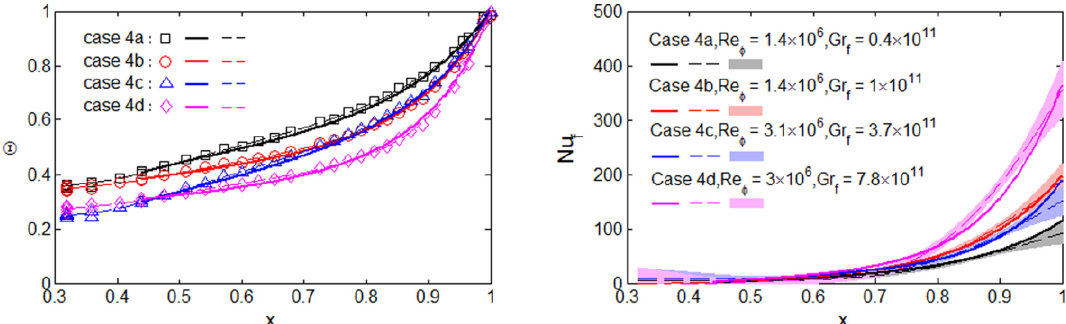
Figure 8. Distributions of temperature and Nusselt numbers for Ro ≈ 0.3. (Symbols denote measured temperatures; broken and solid lines represent experimental and theoretical results respectively; shading shows 95% confidence intervals on experimental Nusselt numbers) [4].